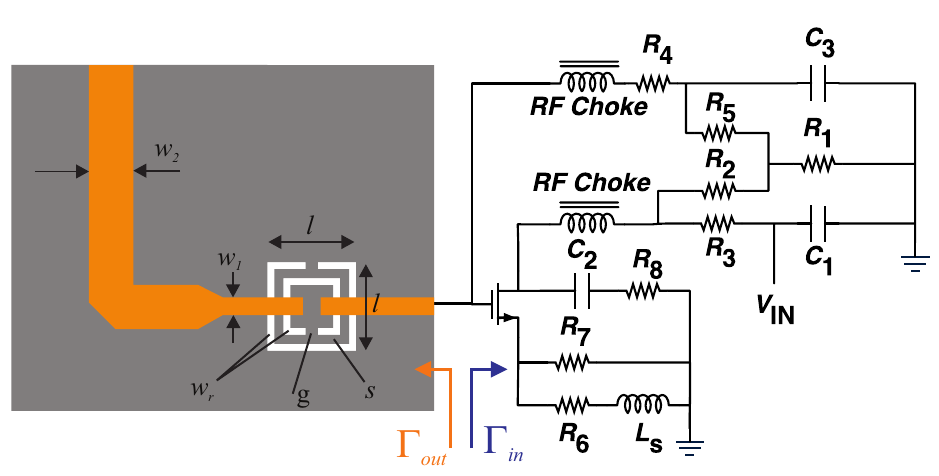
Figure 1. Schematic of the reflective sensor.